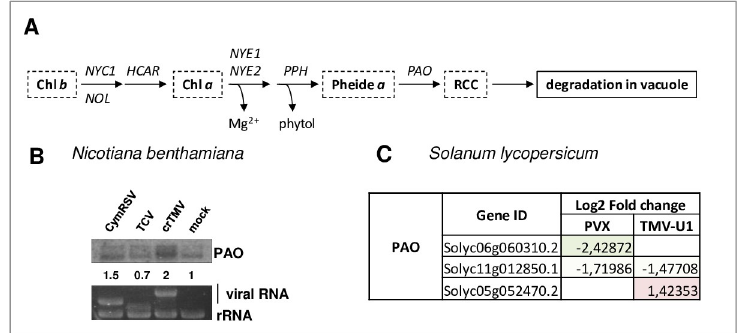
Fig 5. Investigation of the PAO gene expression changes in virus-infected plants. (A) Schematic diagram of the chlorophyll degradation pathway; (B) Northern blot hybridization using radioactively labelled PAO specific probe. Fold-change values are shown below each band (quantifications were normalized to mock control). EtBr-stained gel serves as a loading control. (C) The table shows gene expression changes of S . lycopersicum PAO transcripts. (listed in S13 Table with their characteristic parameters). (Chl b: chlorophyll b; NYC1: non-yellow coloring 1; NOL: nyc1-like HCAR: 7-hydroxymethyl Chl a reductase; Chl a: chlorophyll a; NYEs (NYE1, NYE2): non yellowing; PPH: pheophytinase; Pheide a: pheophorbide a; PAO: pheophorbide a oxygenase; RCC: red Chl catabolite).